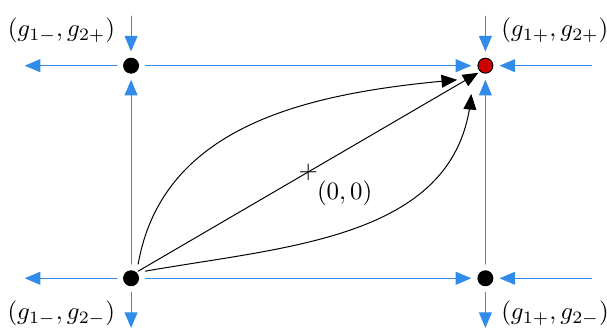
Figure 4 . Trajectory between the fixed points in the space ( g 1 , g 2 ) . The red dot is the IR stable fixed